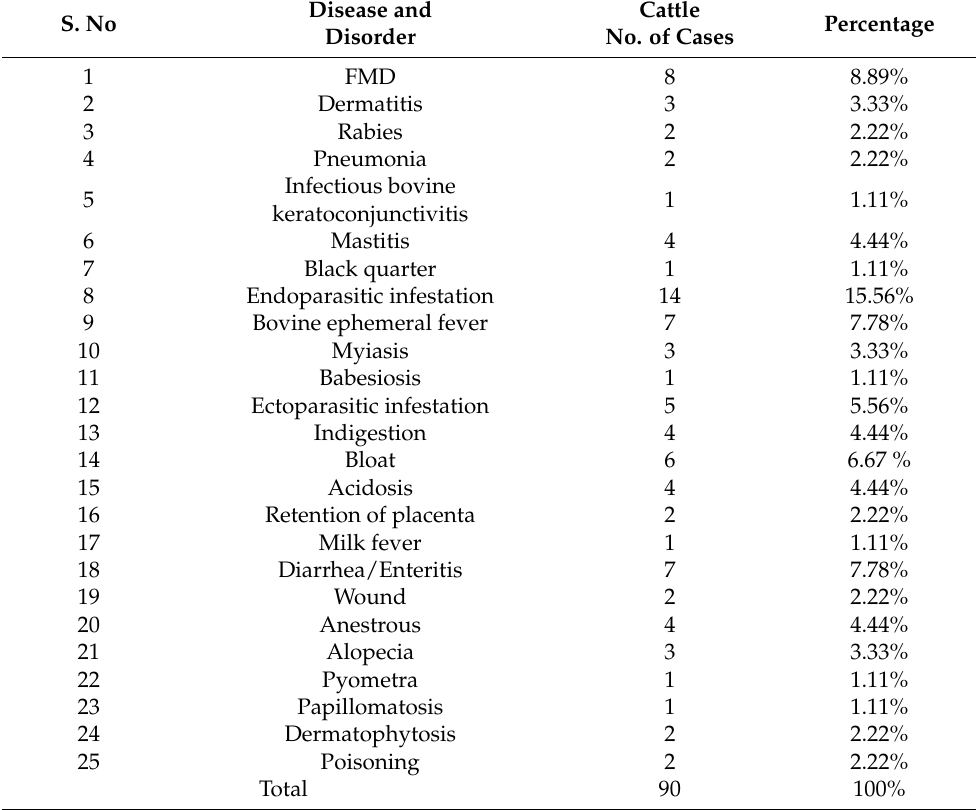
Table 1. Different diseases in cattle with percentages. S. No